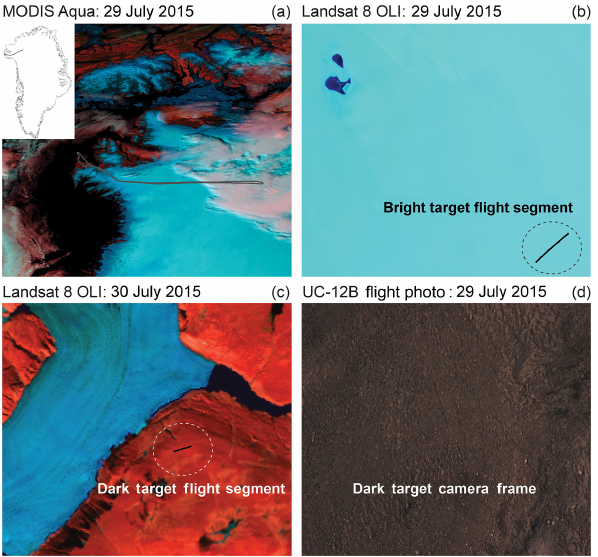
Figure 8. The 29 July flight line showing bright and dark target MODTRAN comparison segments for the nadir-viewing spectrom- eter. Panel (a) shows a MODIS Aqua image (false color SWIR, NIR, green composite) with the UC-12B flight line (grey line). Panel (b) shows a Landsat 8 OLI image (false color SWIR, NIR, green composite) with the bright Greenland ice target flight seg- ment (black line within the black dotted circle). Panel (c) shows a Landsat 8 OLI image (false color SWIR, NIR, green composite) with the dark bare rock/soil target flight segment (black line within the white dotted circle). Panel (d) shows a UC-12B high-resolution visible camera image (true color red, green, and blue composite) frame of the dark bare rock/soil target flight segment. Note: high- resolution visible camera images were acquired over Greenland ice during the campaign science flights.